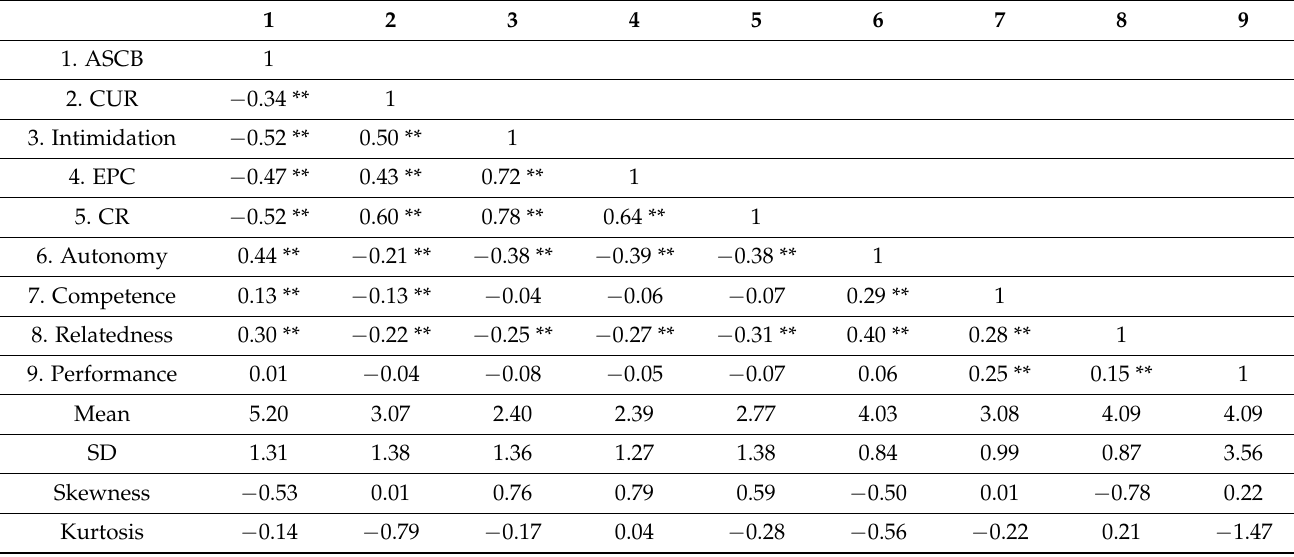
Table 1. Descriptive statistics and correlation analysis.